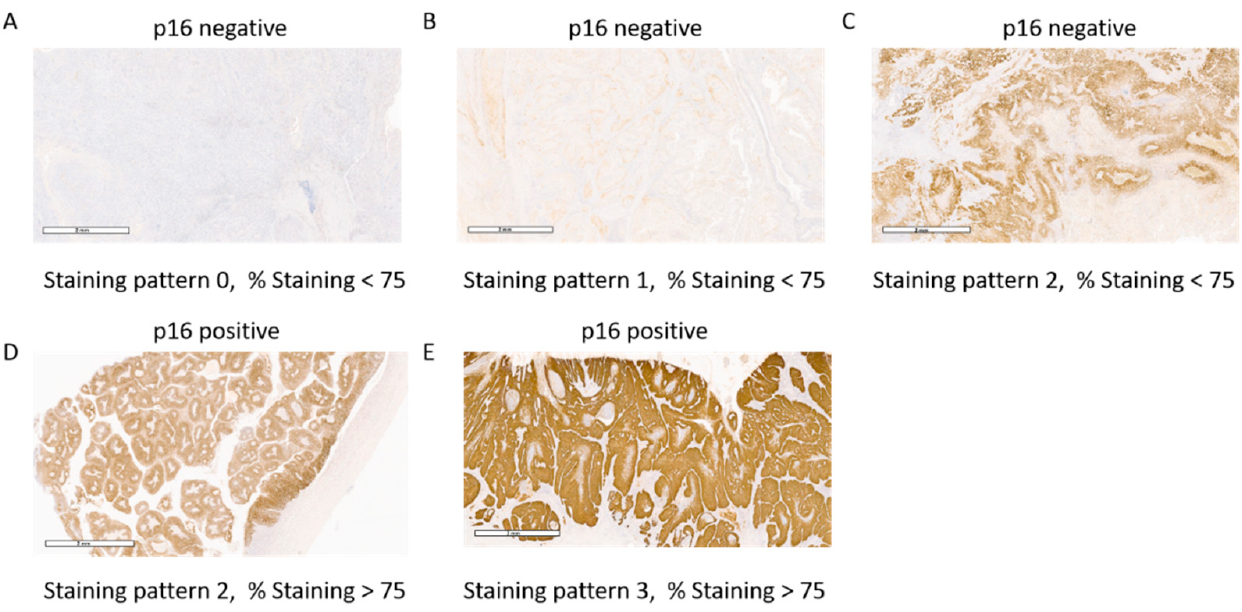
Figure 1. Representative p16 IHC images of PSCC tissue illustrating the staining pattern and the % staining. In our HS-system, staining pattern 0 ( A ), 1 ( B ), and 2 ( C ) with <75% staining are considered p16 negative. Only staining pattern 2 with >75% staining ( D ) and staining pattern 3 with >75% stain- ing ( E ) were considered p16 positive.